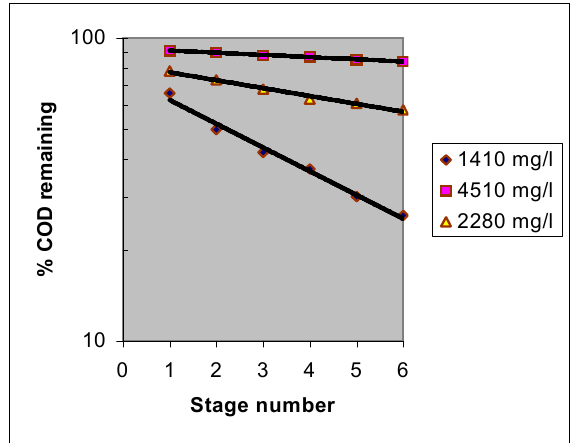
Figure 2: Percent COD remaining per stage for different concentration of wastewater at constant flow rate and velocity. [33]